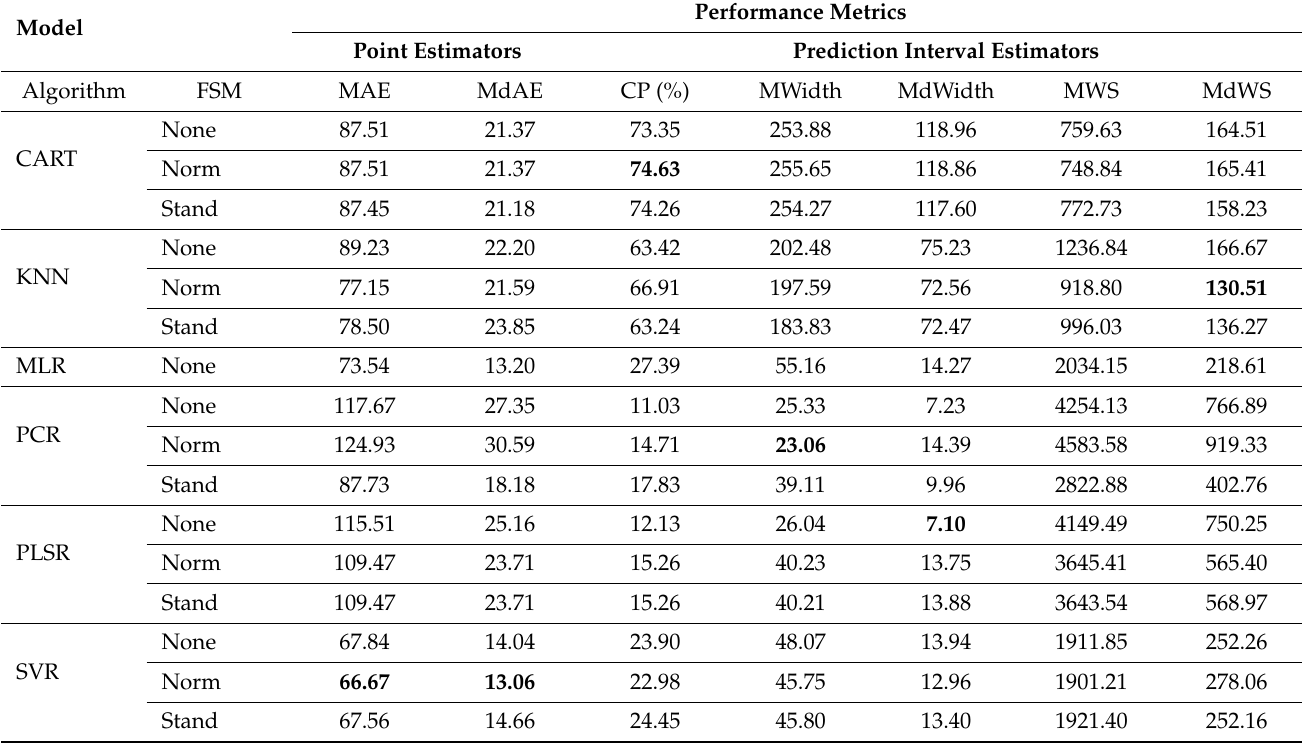
Table 5. Performance evaluation of the examined models (combination of algorithm and